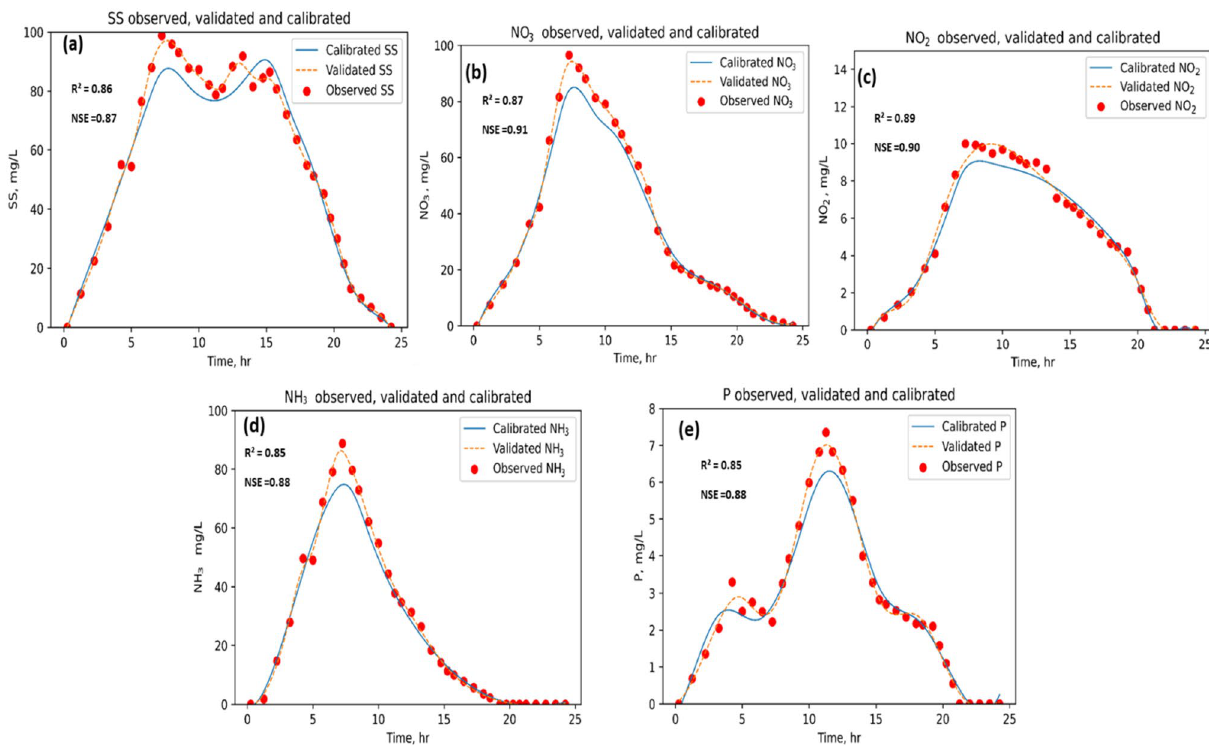
Figure 9. Calibration of the model for pollutant load during the selected